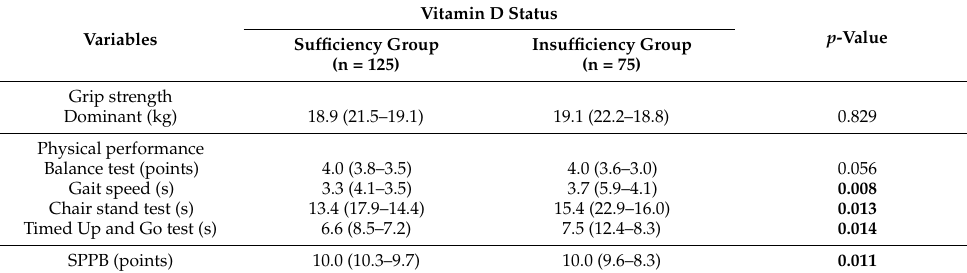
Table 3. Muscle strength and physical performance in LDD patients according to vitamin D levels.